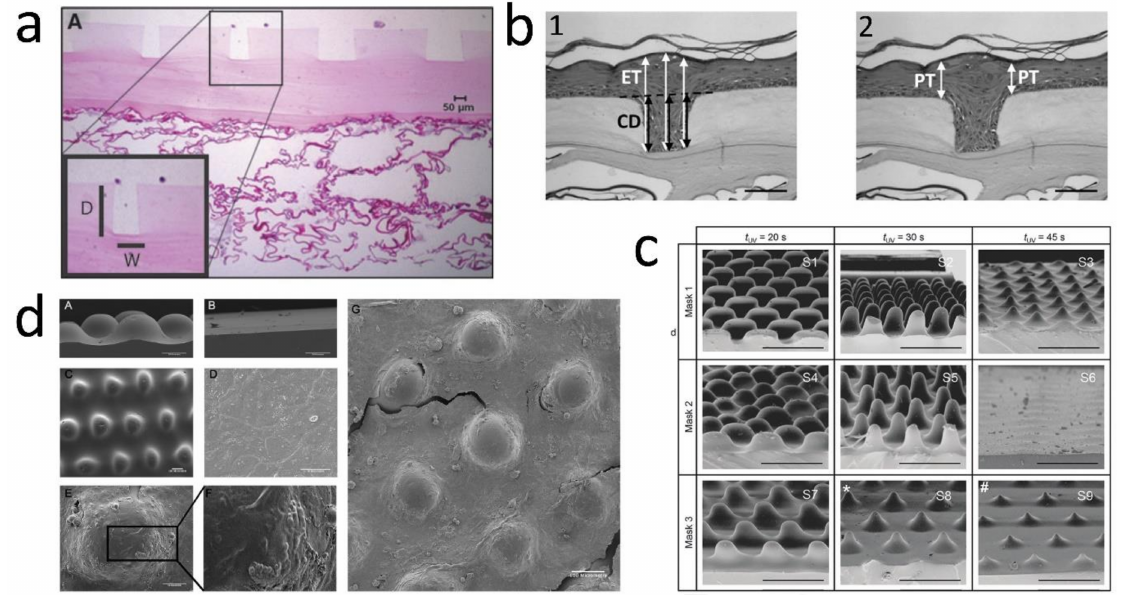
Figure 3. ( a ) µ DERM topography (H&E); the insert illustrates the measurements made for depths (D) and widths (W) of the channels. Photo reused with permission [31] © 2012 Tissue Engineering: Part A, Mary Ann Liebert, Inc. ( b ) Morphometric analyses of epidermal thickness in K microniches; (b1) The epidermal thickness (ET) is enhanced in the narrow channels, normalized by the channel depth (CD). (b2) The plateau thickness (PT) was measured immediately adjacent to each channel. Scale bar = 100 µ m. Photo reused with permission [13] © 2013 Acta Materialia Inc. Published by Elsevier Ltd. ( c ) SEM images of the patterned substrates fabricated by using 3 different masks. PHEMA molding precursor was exposed to UV light for 3 different intervals. Scale bars: 400 µ m. Photo reused with permission [112] © 2015 Integrative Biology, Oxford University Press. ( d ) SEM images of ( A ) patterned, ( B ) flat PDMS substrates before COL coating, ( C ) top view of patterned PDMS substrate before COL coating, ( D ) keratinocytes on flat, and ( E – G ) keratinocytes on undulating PDMS substrates. ( F ) A higher magnification view of the boxed region in ( E ). Scale bars: 100 µ m and 50 µ m ( D , E ). Photo reused with permission [113] © 2019 Acta Materialia Inc. Published by Elsevier